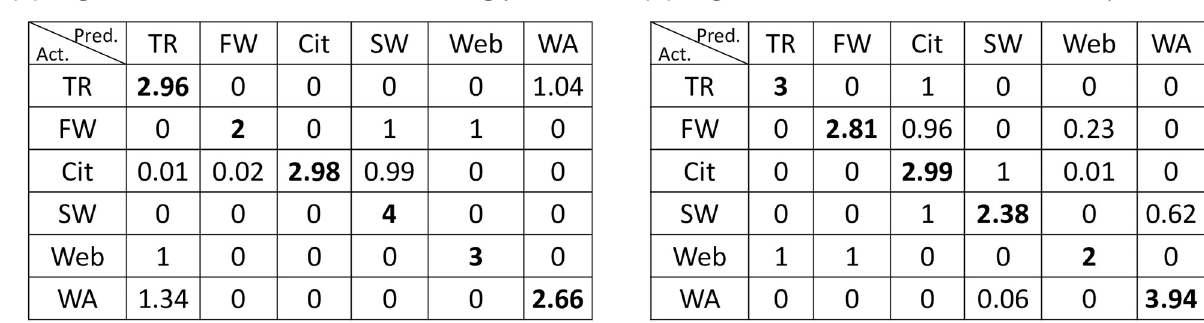
PLOS ONE | https://doi.org/10.1371/journal.pone.0253822 June 25,